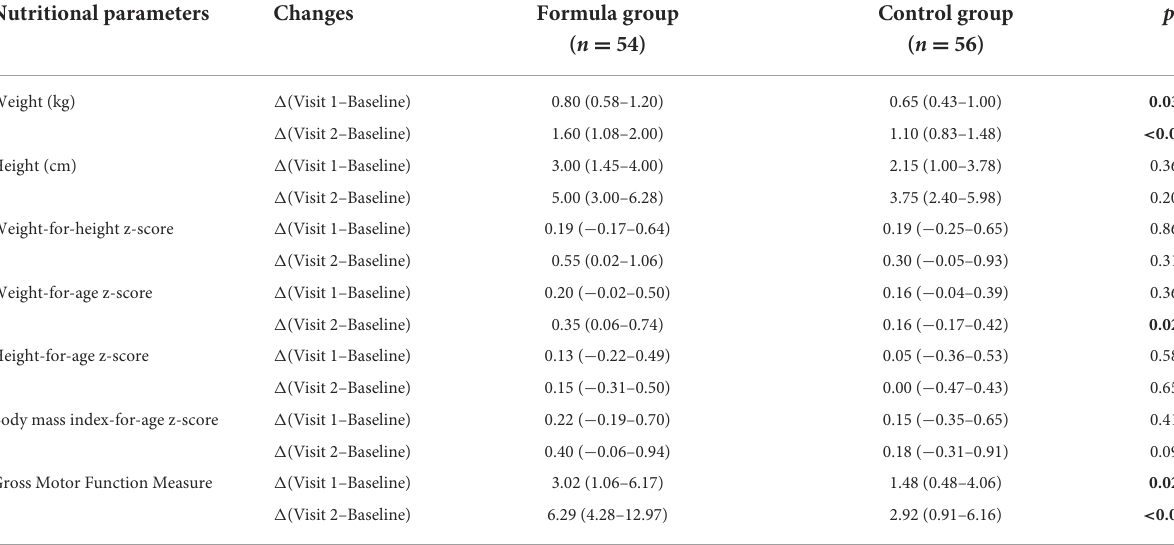
TABLE 3 Between-group comparison of changes in nutritional parameters and GMFM scores.